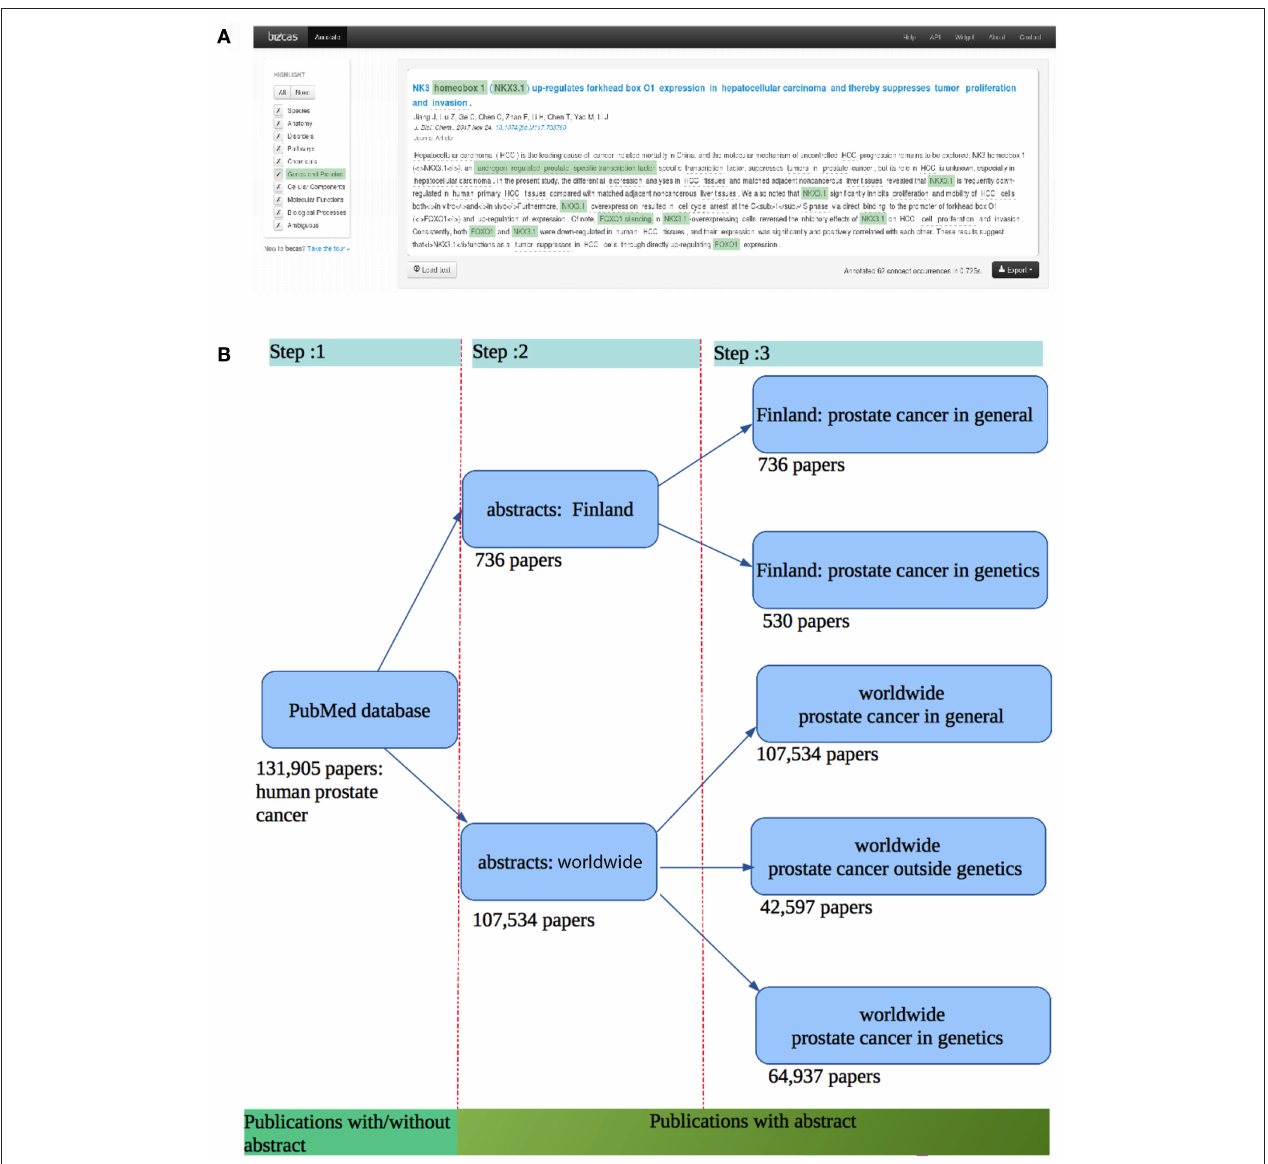
FIGURE 1 | (A) Entity recognition step using the becas web API giving an annotation of PubMed abstracts (Nunes et al., 2013). (B) Data collection steps and the corresponding publications